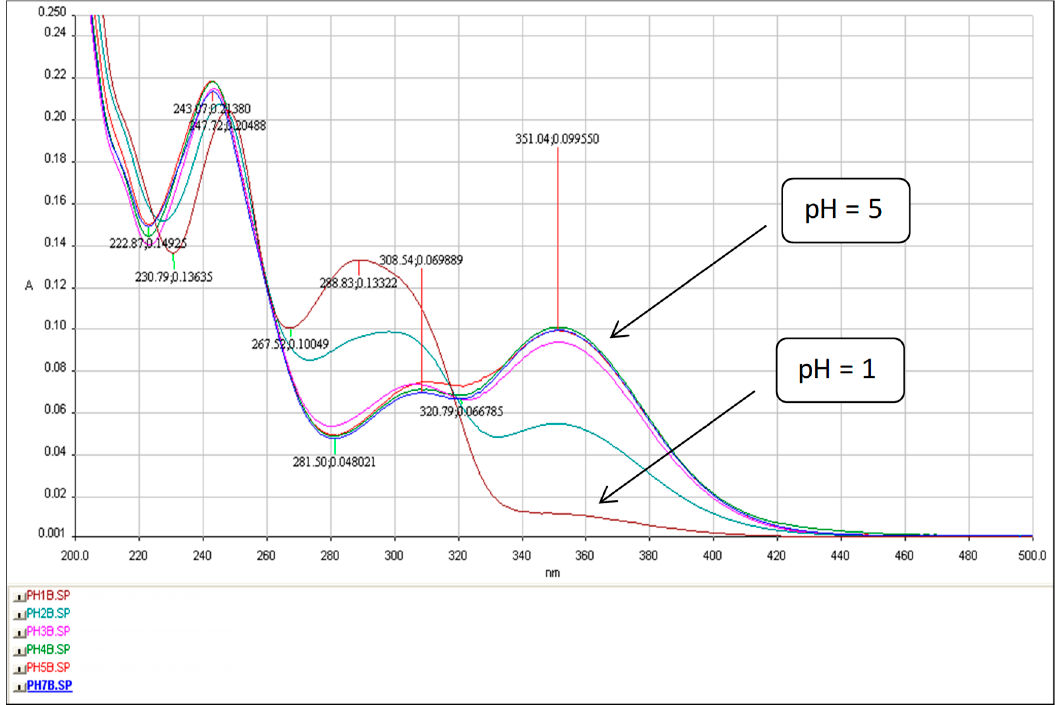
Figure 11. UV-Vis spectra of 3-aminoflavone (c = 5 µ g / mL) in HCl solutions at pH = 1, 2, 3, 4, 5. l = 1 cm.